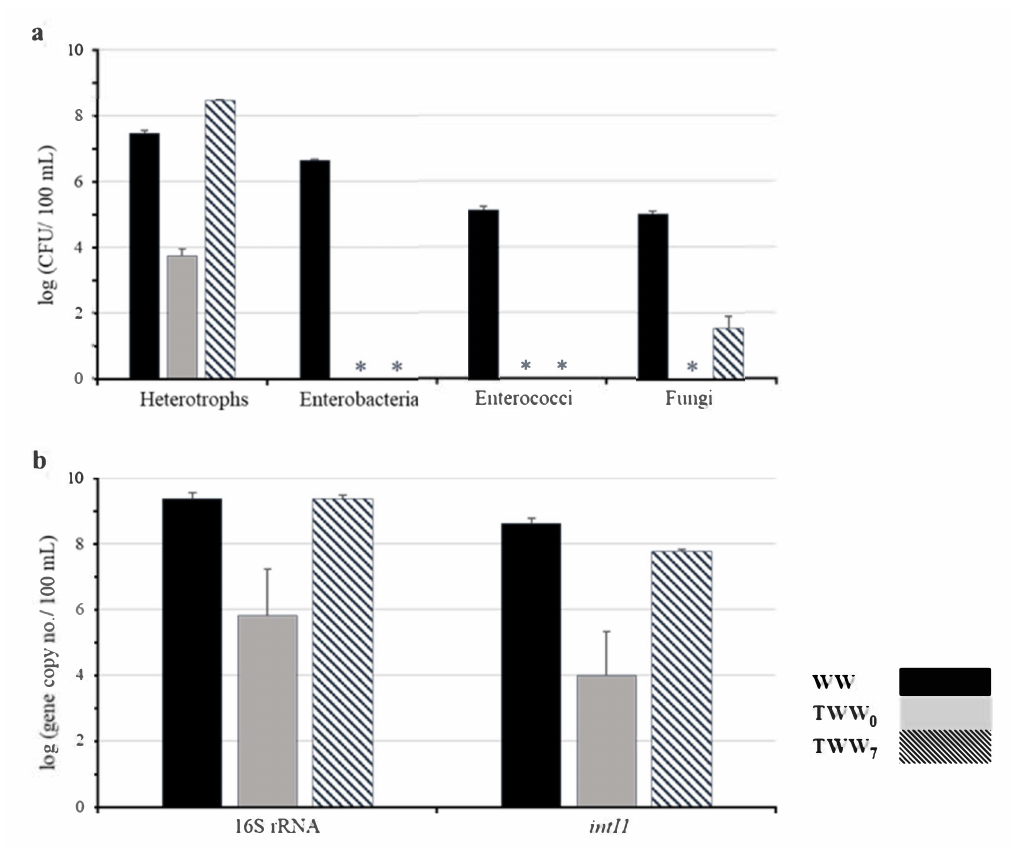
Figure 3. Microbiological water quality. ( a ) Culturable heterotrophs, enterobacteria, enterococci, and fungi, expressed as log (CFU / 100 mL of sample); and ( b ) qPCR-based quantification of 16S rRNA and intI1 genes, expressed as log (gene copy number / 100 mL of sample). * below the detection limit (0.33 CFU / 100